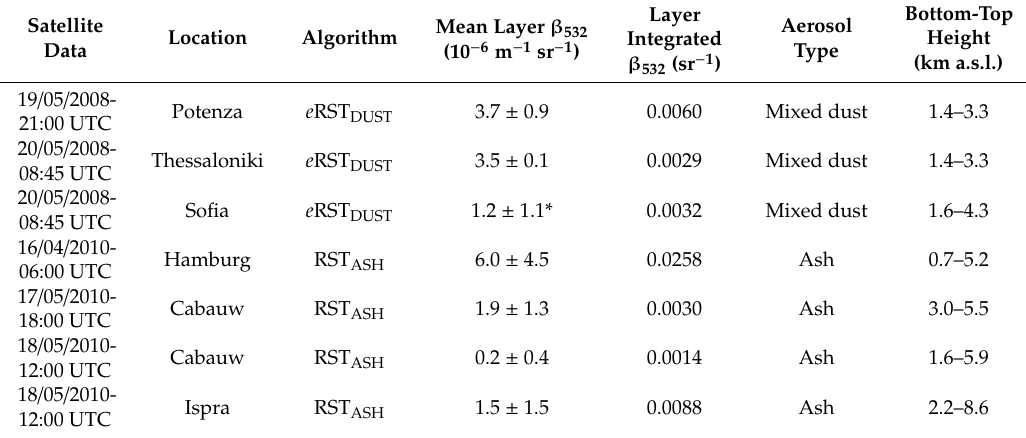
Table 1. e RST DUST and RST ASH detections corroborated by EARLINET lidar measurements. The mean- layer backscatter coe ffi cient ( β 532 ) at 532 nm along with the standard deviation, the layer integrated backscatter coe ffi cient at 532 nm, the aerosol type, and the bottom-top layer height are provided by EARLINET. (*) The operating wavelength of the Sofia EARLINET station is 510